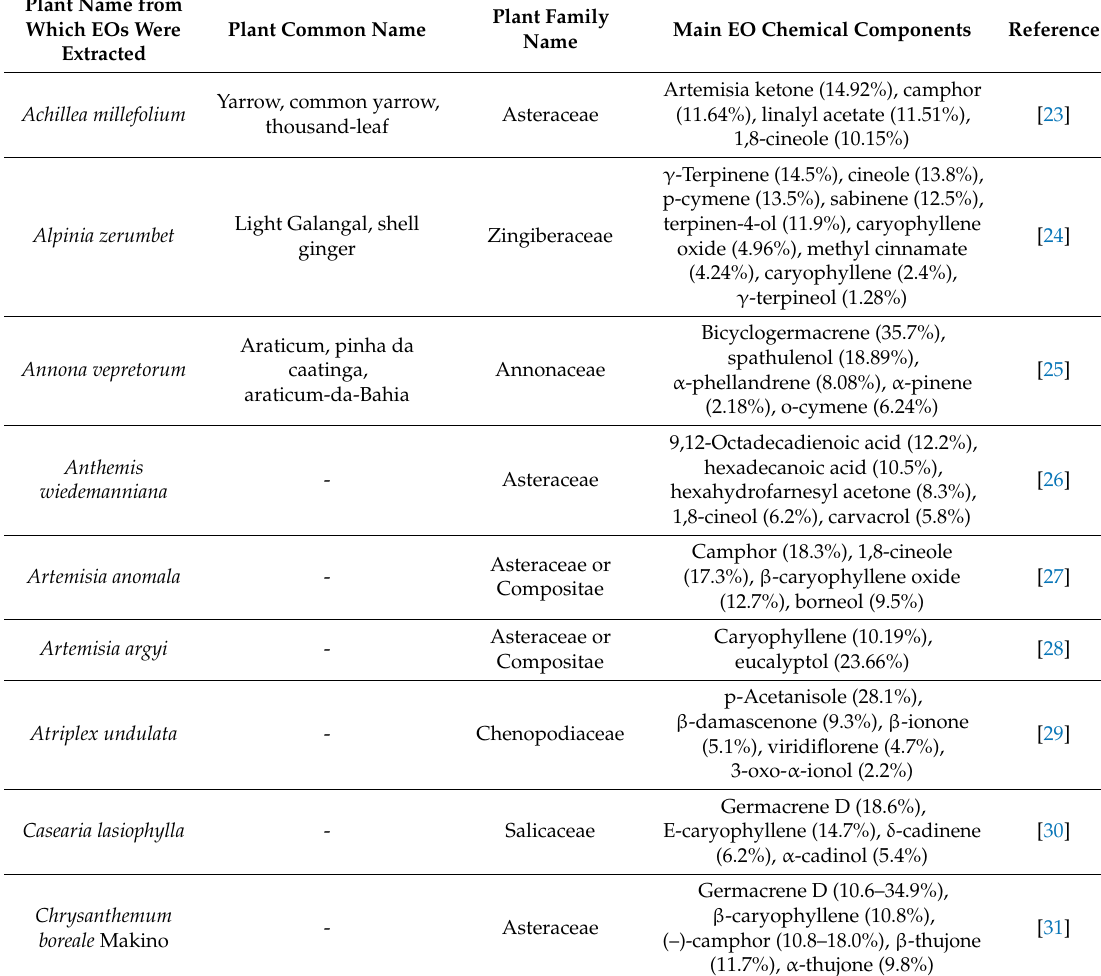
Table 1. Chemical composition of essential oils (EOs) active against melanoma